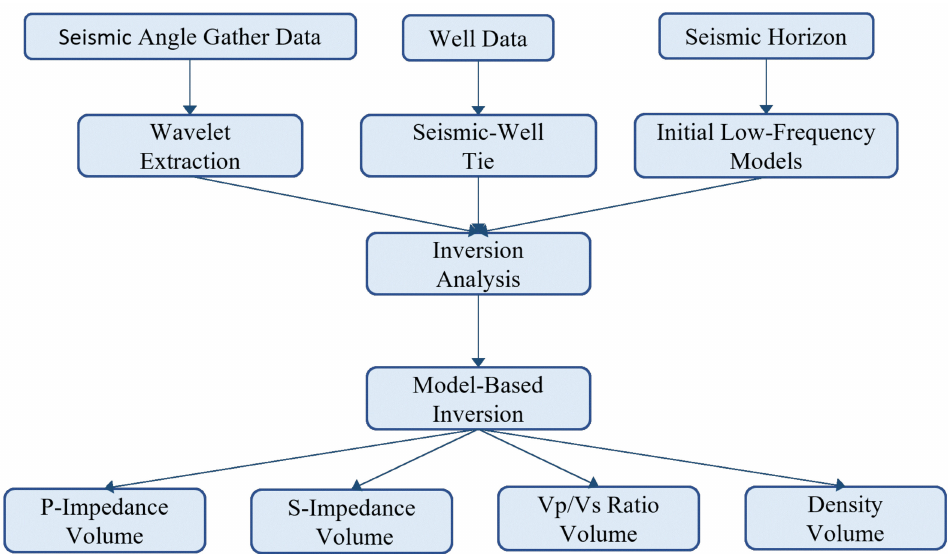
Figure 6. The workflow of the pre-stack inversion